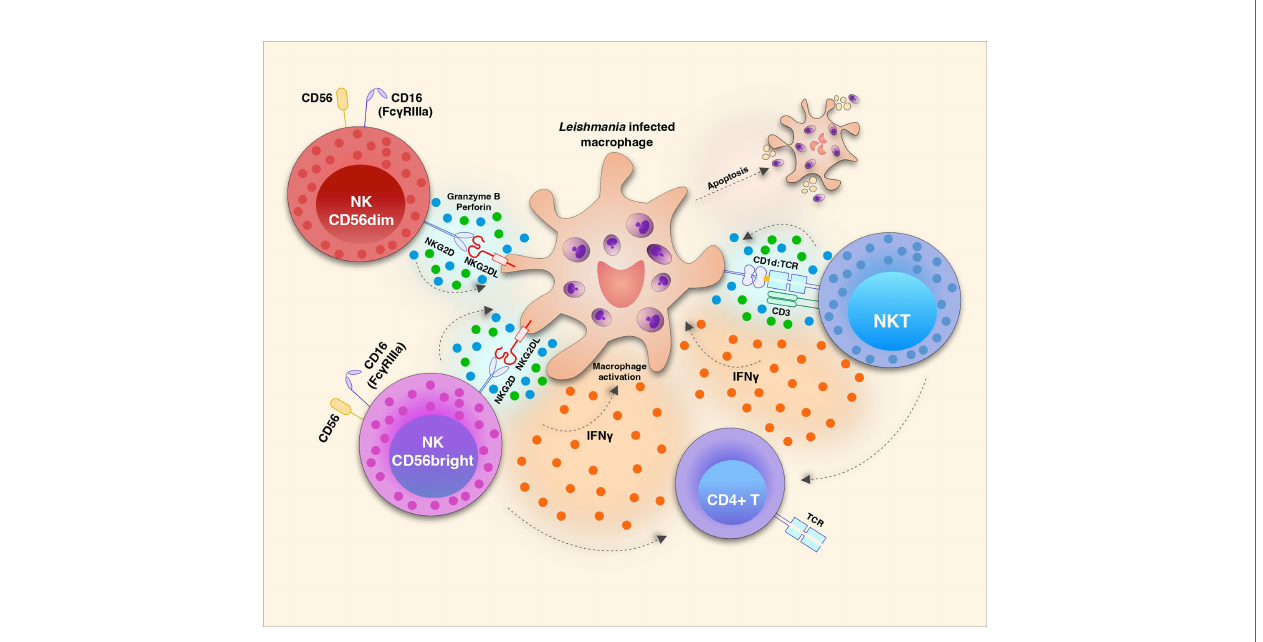
FIGURE 1 | Natural killer (NK) cell subsets play distinct roles during Leishmania infection. NKG2D/NKG2D ligand (L) interaction triggers the effector function of CD56 dim (also CD16 + in humans) NK cells to release cytotoxic granules with Granzyme b and Perforin which induces apoptosis of Leishmania infected macrophages. It is not yet clear tough if this mechanism restricts parasite growth or amplify amastigote proliferation. The same receptor-ligand interaction induces the activation of CD56 bright NK cells which are strong producers of cytokines such as IFN- g and TNF which in turn can act in the activation of macrophages and T cells. The potential recognition of glycolipid antigens present by CD1d to the invariant TCR of NKT cells may induce the production and release of IFN- g and also apoptotic factors Granzyme B and